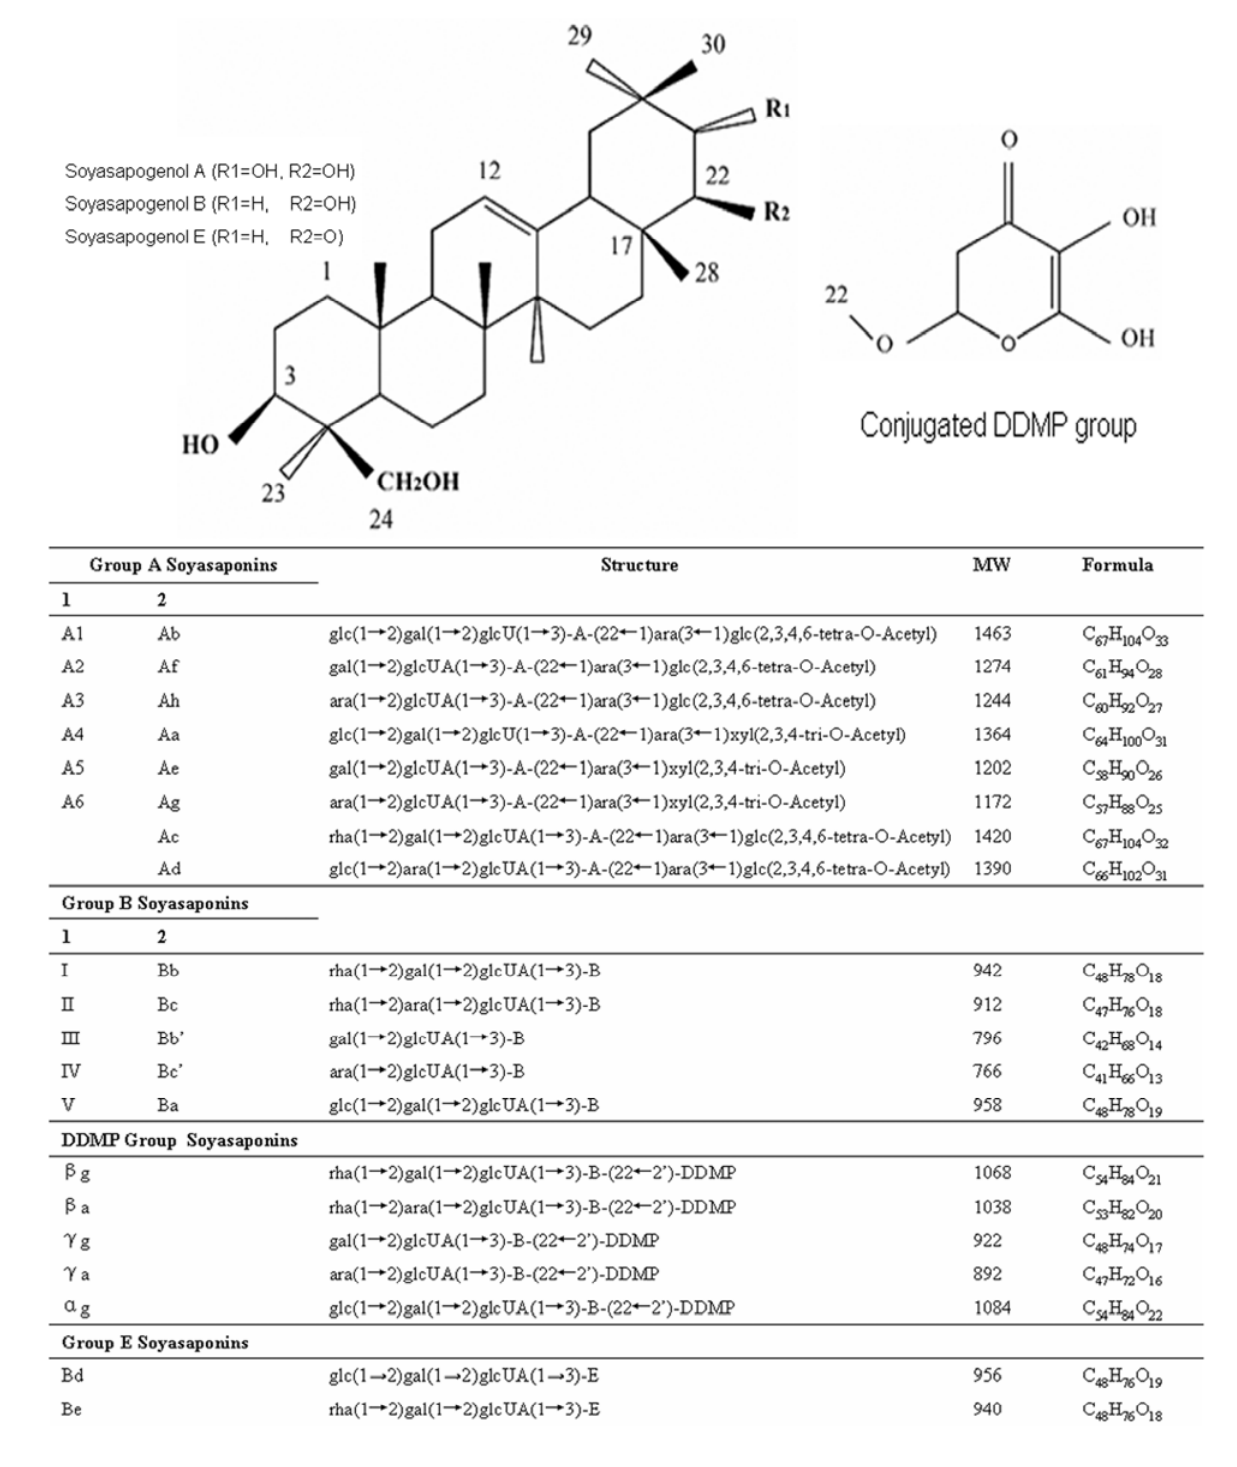
Figure 1. The chemical structures and molecular weights of